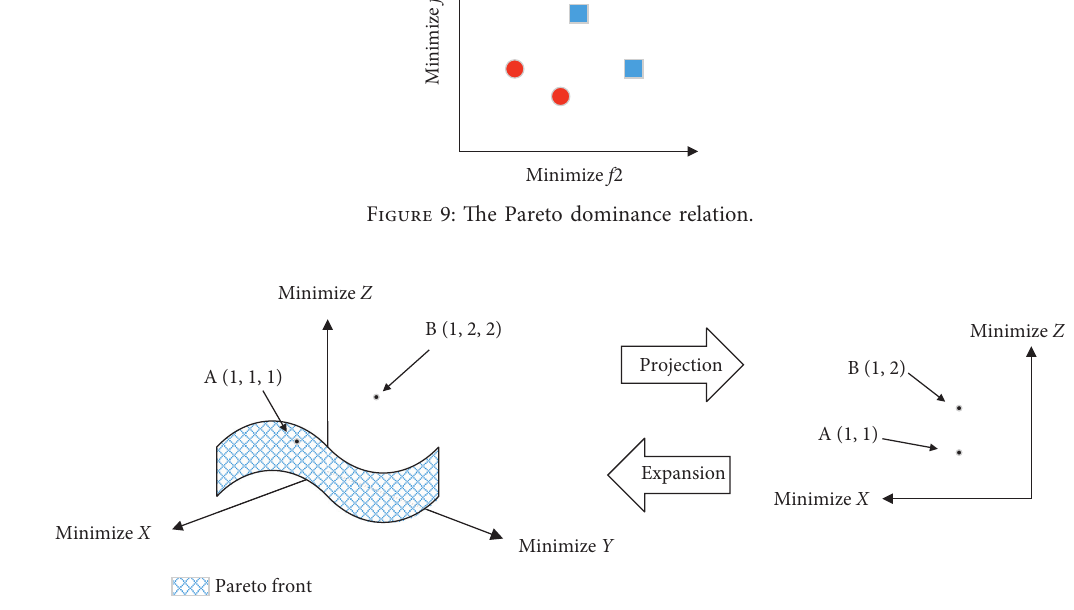
Figure 10: The relation between multiobjective problem and subproblem.